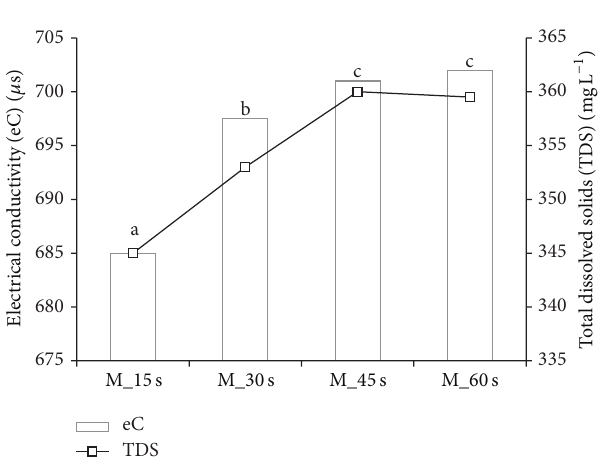
Figure 5: Electrical conductivity (eC) and total dissolved solids (TDS) of barley milk (M) after 15, 30, 45, and 60 seconds of blending. Means with different letters are significantly different ( 𝑝 < 0.05